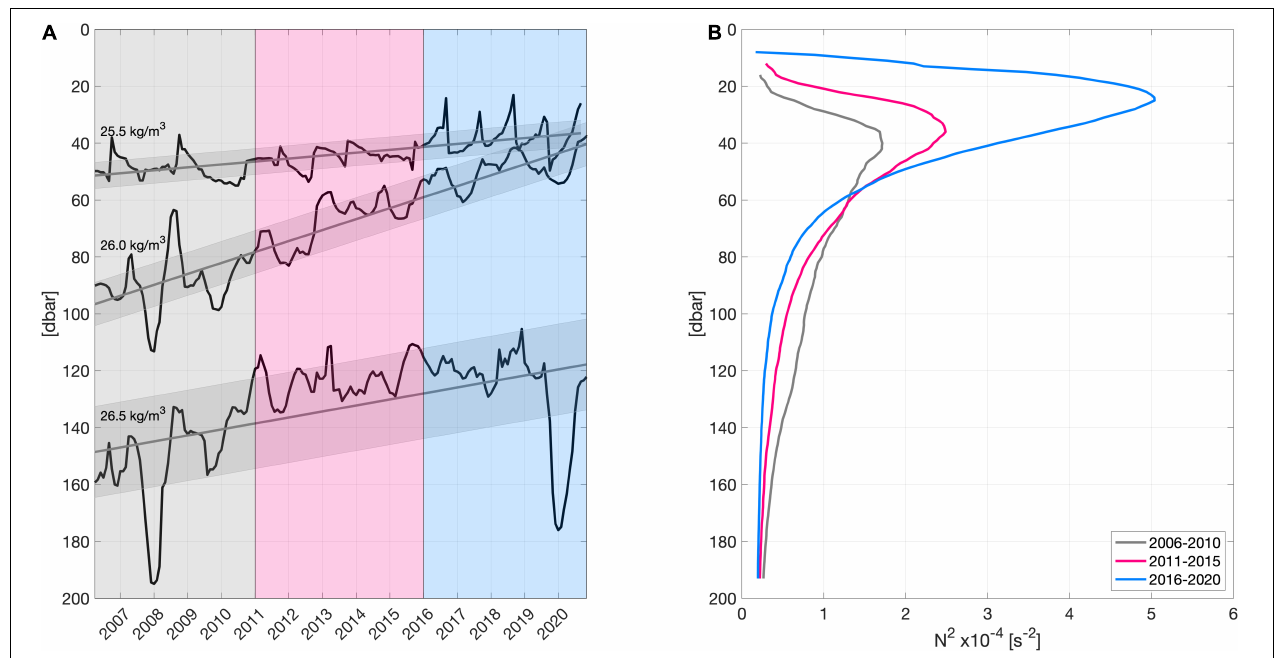
FIGURE 9 | (A) Six months running median pressure anomaly of three isopycnals (25.5, 26.0, and 26.5 kg m − 3 ) plus their corresponding mean pressure in the SETA region (10–20 ◦ S, 5 ◦ W–15 ◦ E). For each isopycnal the linear trend (gray line) and its standard error are shown (gray shading around the linear trend lines). Shaded areas indicate the time periods for the corresponding mean Brunt–Väisälä frequency profile of the upper 200 dbar in (B) . Gray shows the mean for the time of 2006–2010, pink denotes the mean of 2011–2015 and blue indicates the period of 2016–2020.